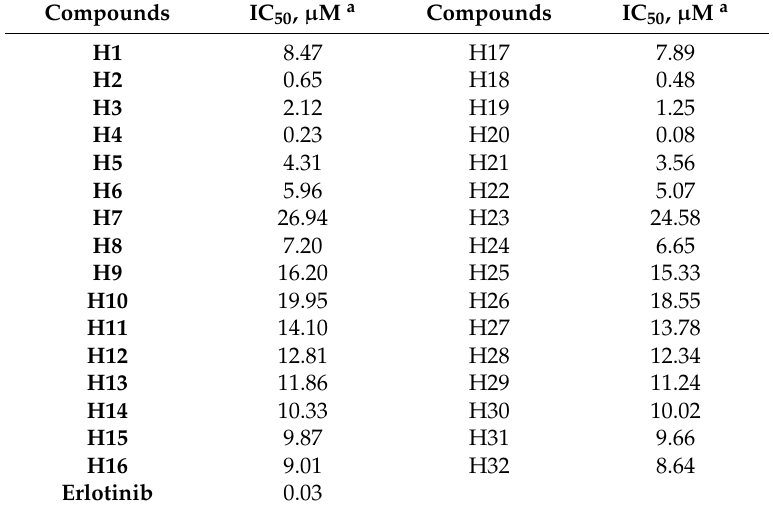
Table 3. Inhibition activities (IC 50 , µ M a ) of all compounds against epidermal growth factor receptor (EGFR). Compounds IC 50 , µ M a